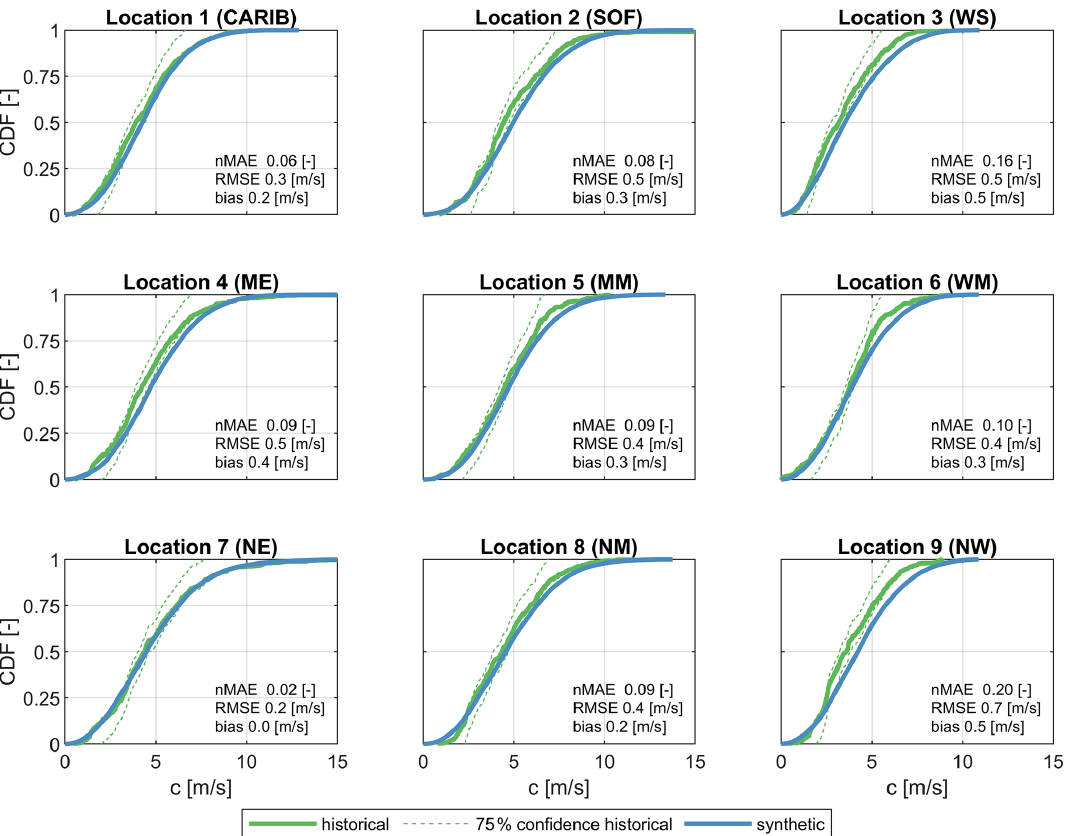
Figure 6. CDFs of forward speed ( c [ms − 1 ]) of historical (green line) and synthetic (blue line) TCs at nine locations within the NA basin, as shown on the map in Fig. 2. The 75% confidence interval (dashed green line) of historical data is also shown. Historic data are based on data available between 1886 and 2019, while synthetic data are derived from 10000 years of simulated events with TCWiSE. Data points within 200km from the control location are included in the analysis for both the historical and synthetic